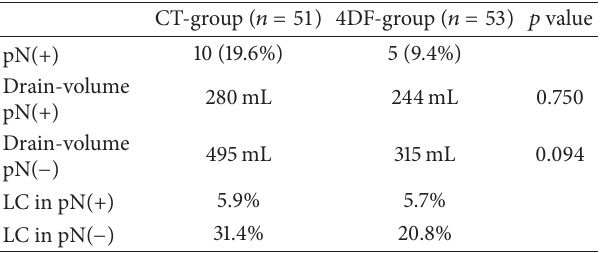
Table 3: Involvement of lymph nodes and drain loss/LC develop-